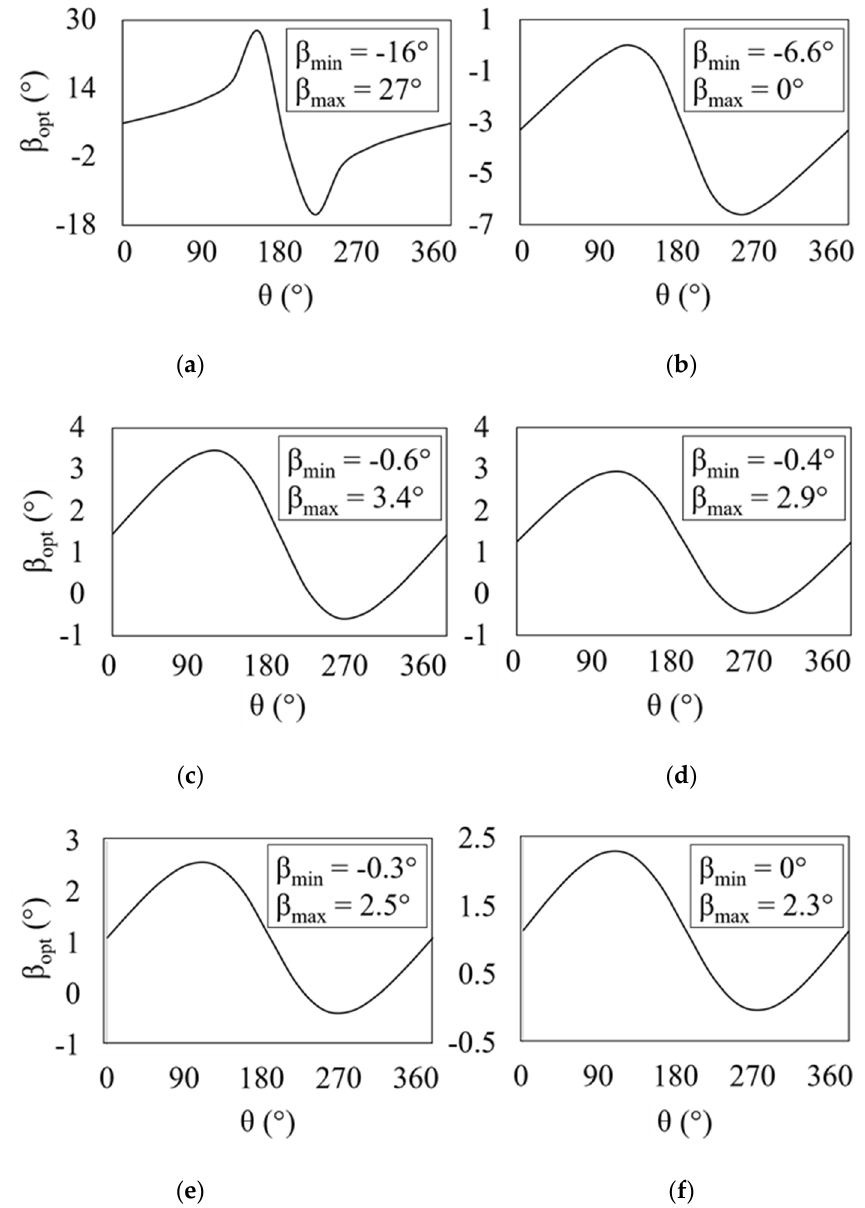
Figure 13. Optimized pitch angle for one turbine rotor rotation: ( a ) TSR = 1, ( b ) TSR = 2, ( c ) TSR =